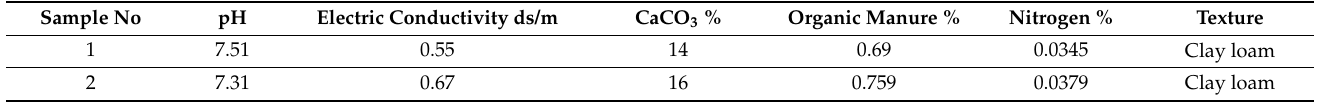
Table 1. Parameters studied in soil